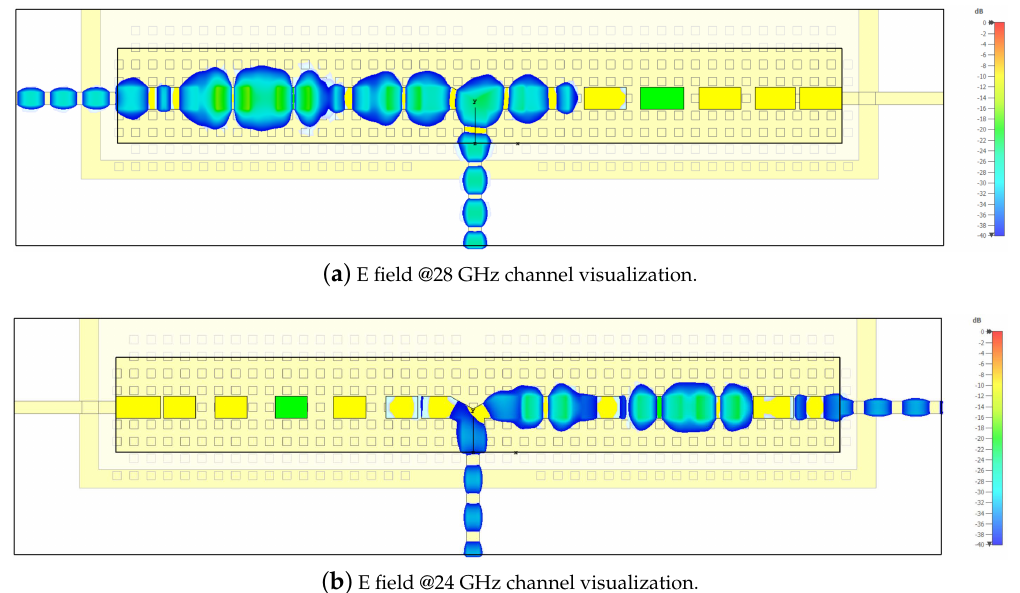
Figure 9. Normalized to maximum absolute dB value E field cross section at half height gap of RT5880 TM substrate